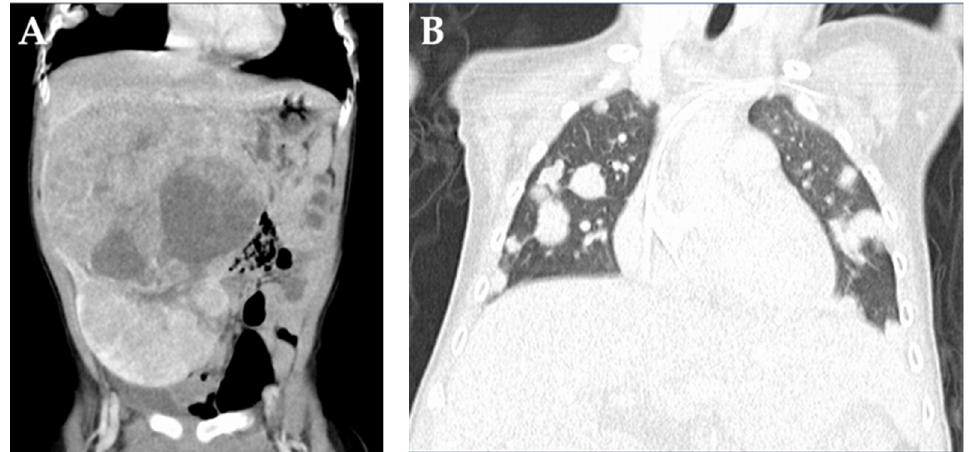
Figure 1. Computed tomography findings on admission. ( A ) A large tumor is located in the right lobe. ( B ) Multiple metastatic pulmonary nodules are observed in both lobe. ( B ) Multiple metastatic pulmonary nodules are observed in both lungs.